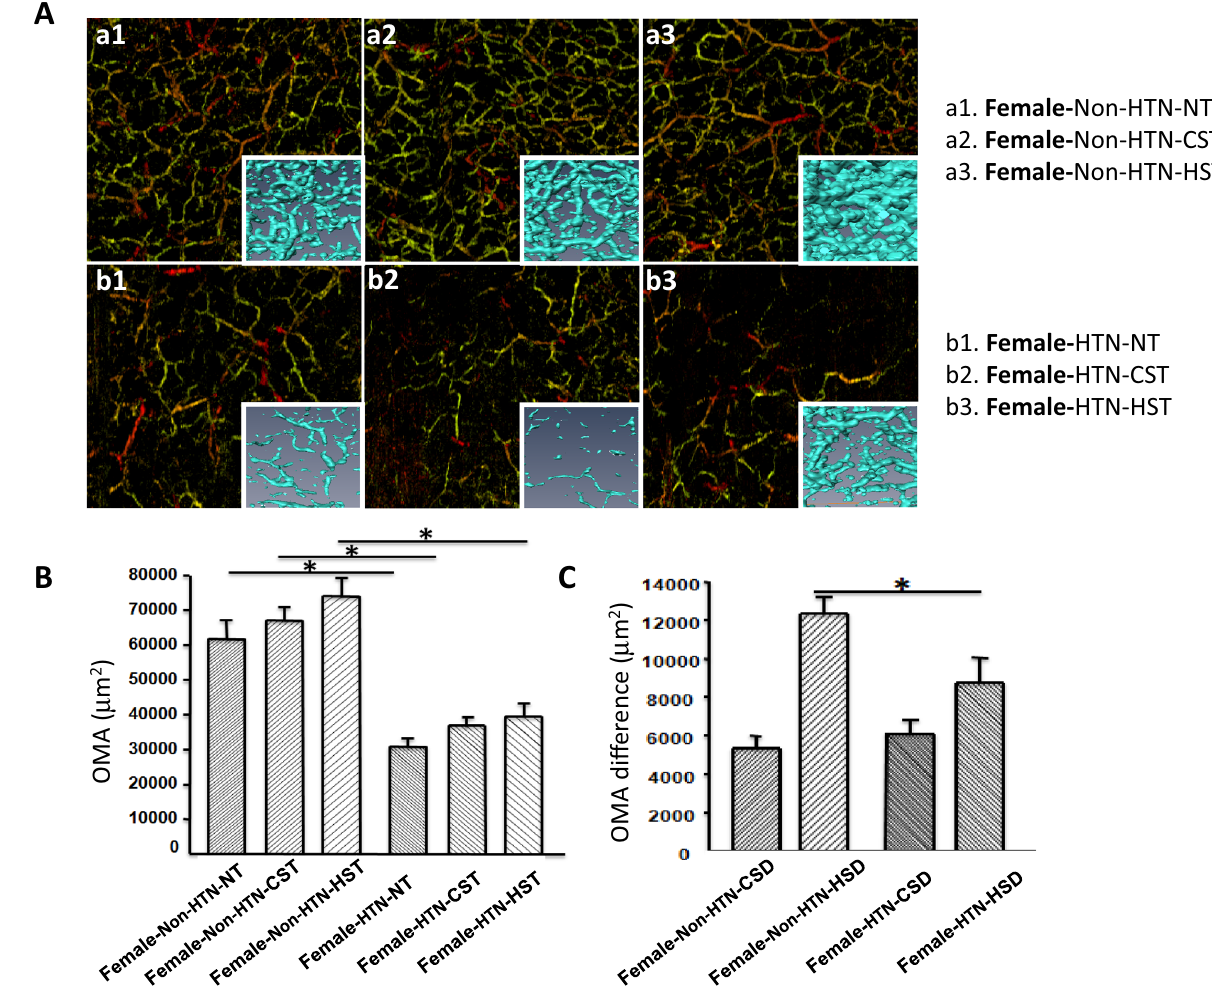
Figure 4. ( A ) Microvascular network imaging under the back of the hand, three-dimensional blood vessel model imaging, a1 NT, a2 CST, a3 HST in non-HTN, b1 NT in female HTN, b2 CST in female HTN, b3 HST in female HTN; ( B ) Variance histogram of blood vessel area; ( C ) Difference of blood vessel area Variance histogram; non-HTN n = 18, HTN n = 25, *mean NT, CST, HST, CSD, HSD in non-HTN and NT, CST, HST, CSD, HSD in HTN, p <